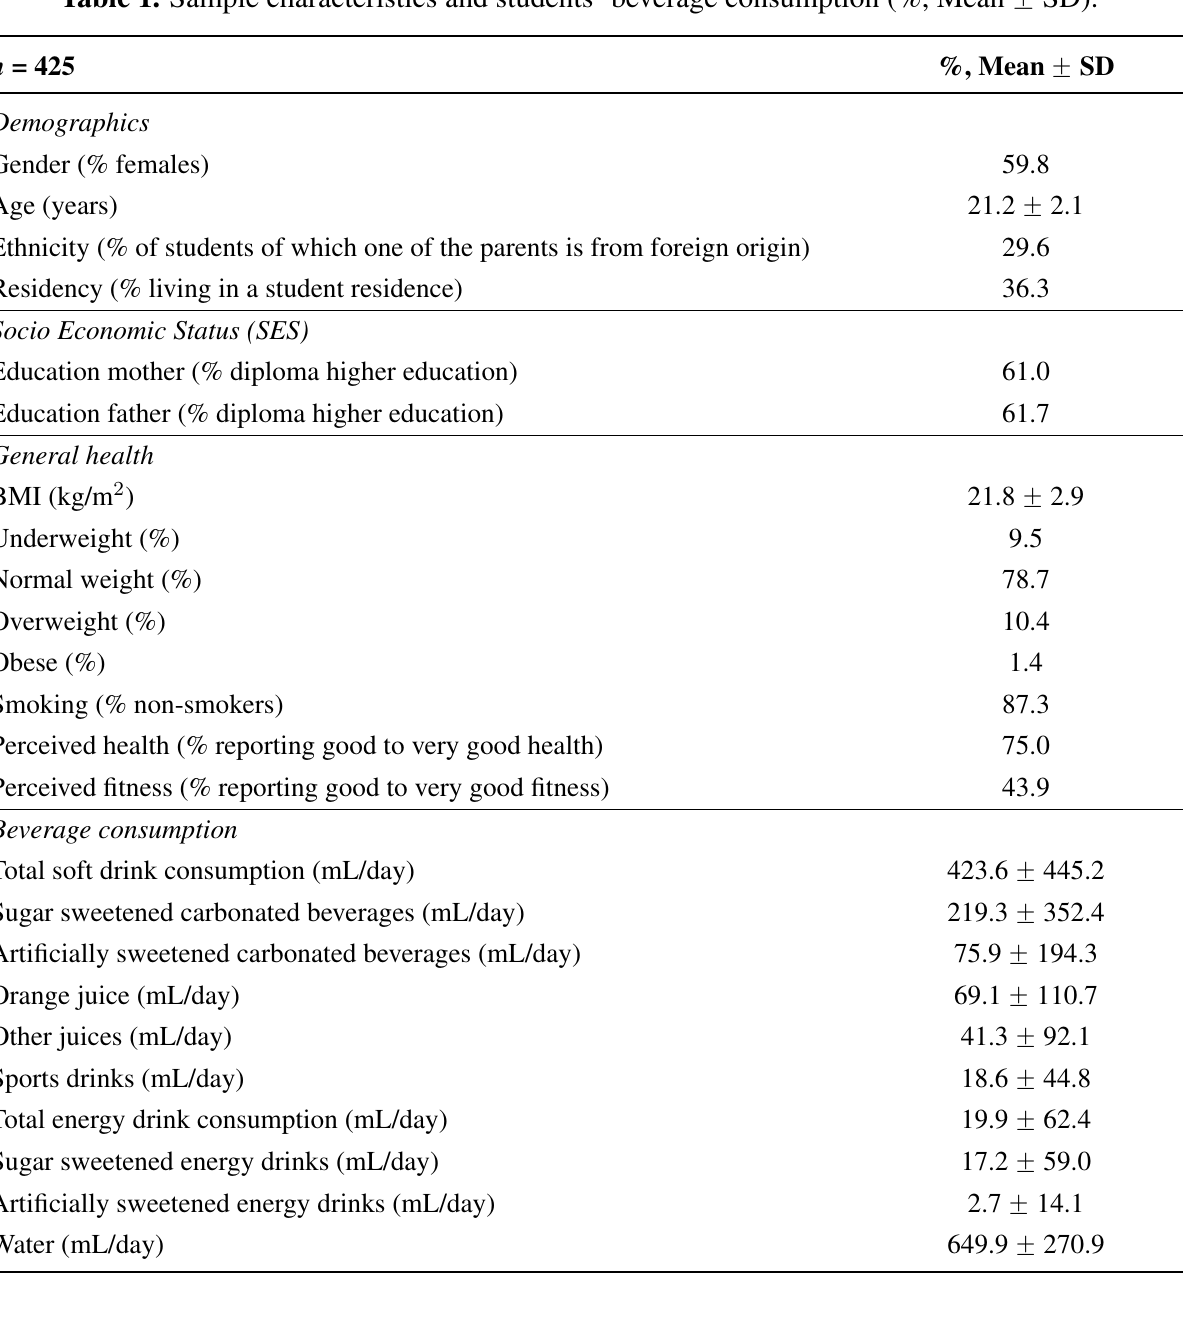
Table 1. Sample characteristics and students’ beverage consumption (%, Mean ˘